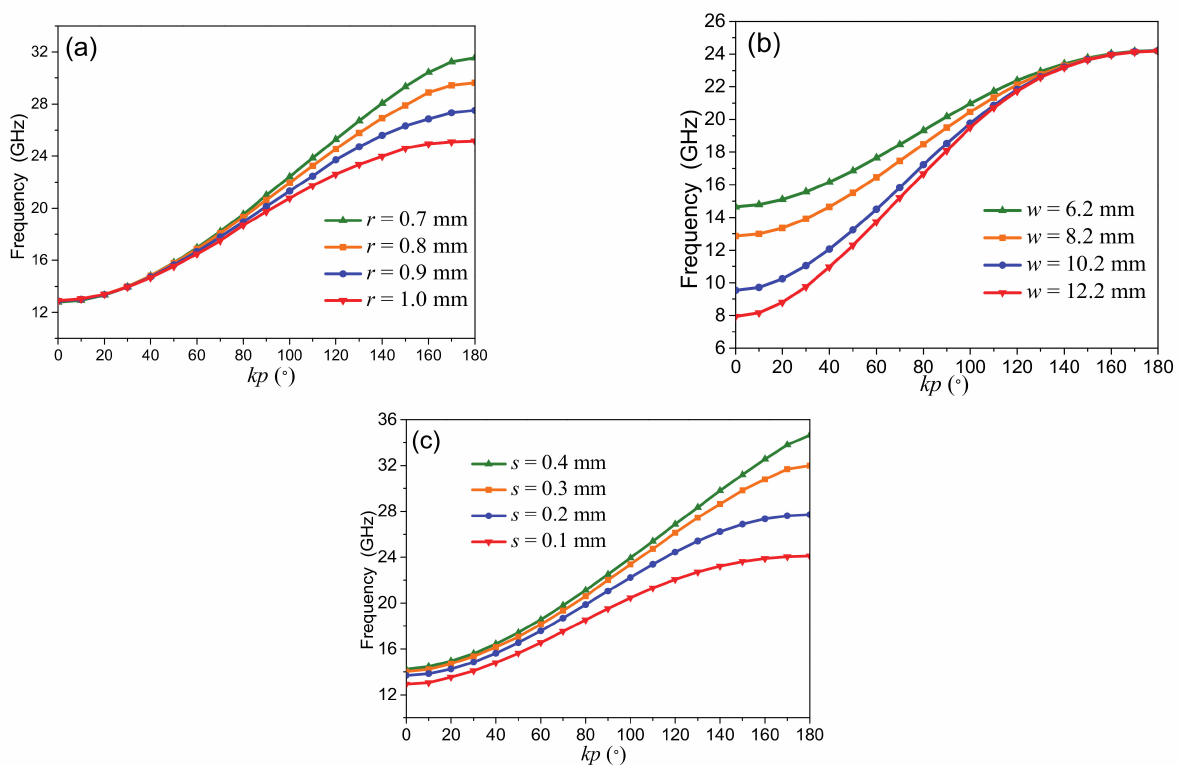
Figure 2. Dispersion curves of the proposed SSPP unit cell ( a ) with different r , ( b ) with different w , and ( c ) with different s .